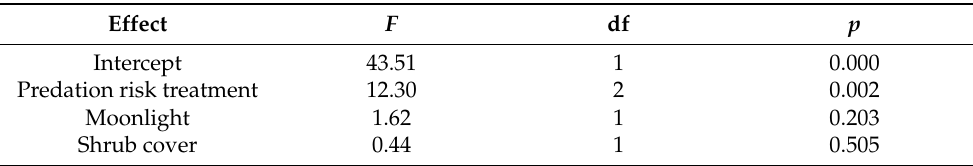
Table 9. Results of the GLM analyzing the effect of experimental and environmental factors on R. rattus feeding behavior.